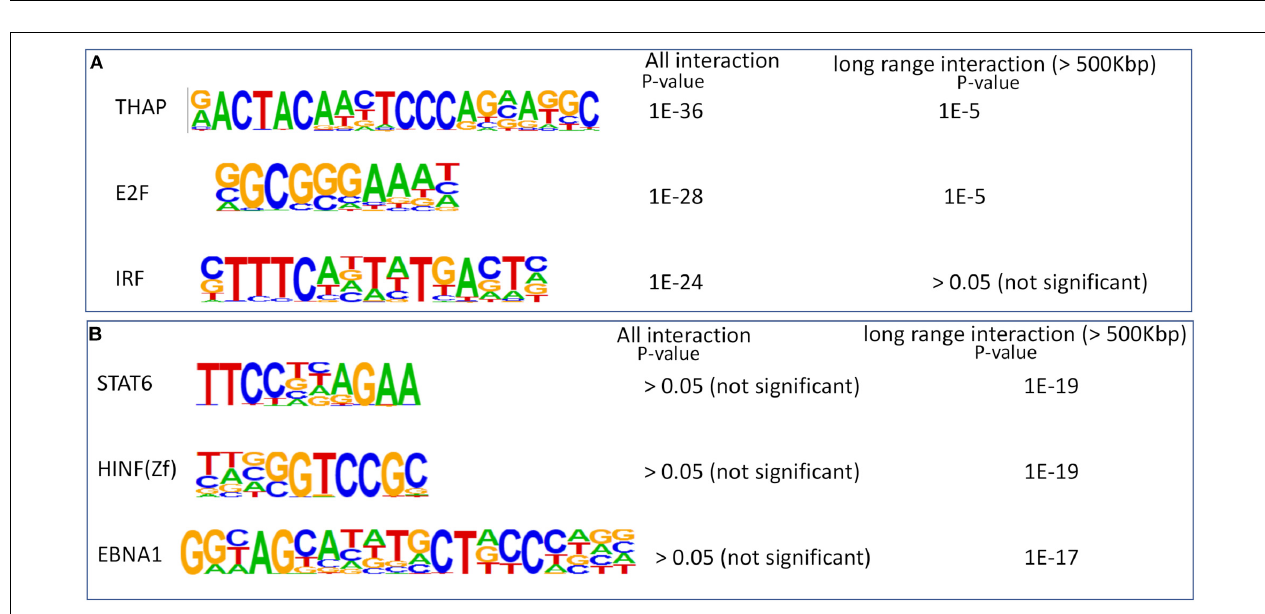
FIGURE 6 | Enrichment of transcription factor motifs at sites with predicted chromatin-interaction in endothelial cells. (A) Top 3 enriched motifs at sites with all kinds of chromatin interaction (both short and long-range). The p -value of enrichment in two types of sites (all and only long-range) are also shown. (B) Top 3 enriched motifs at sites with long-range chromatin interactions. The p -values of enrichment in two types of sites are also shown. None of the top 3 enriched motifs in sites with predicted long-range interaction is enriched in loci with all predicted interactions.